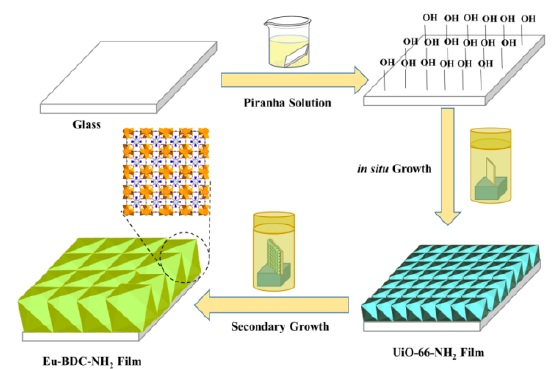
Figure 5. Synthetic route of a Eu-BDC-NH 2 film by an in situ secondary growth method with a UiO-66-NH 2 film as the seed layers. Reprinted with permission from Reference [62]. Copyright 2018 Elsevier.